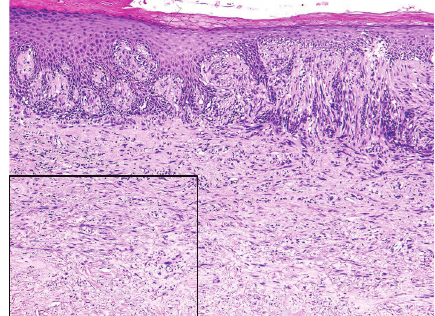
Figure 2: Histologic features of primary penile desmoplastic melanoma. Low-power photomicrograph of the penile glans depicts haphazardly arranged spindle tumor cells permeating in between collagen bundles and deeply infiltrating the dermis and corpus spongiosum within. In intimate association with the spindle tumor cells are focal atypical intraepidermal melanocytic proliferation and pseudoepitheliomatous hyperplasia in the overlying epidermis (left half of the H&E). S-100 is strongly positive in the spindle tumor cells (small